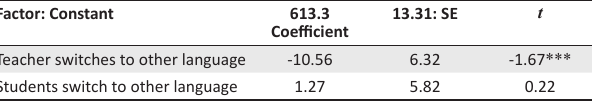
TABLE 6: Model results for the effect of codeswitching by teachers and students. Factor: